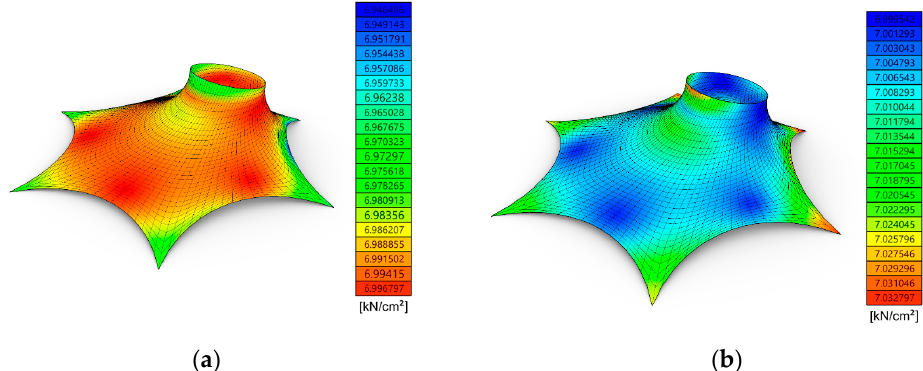
Figure 8. Analysis of tensile forces in form-found membrane in the ( a ) latitudinal and ( b ) longitudinal directions. Differences in tensile forces occur as a function of the directions. Both stocking- and soap-film-based form-finding methods are burdened with built-in errors (elastic deformation forces and scale limits), which also overlap with the digitalization issue. Although very useful for educational reasons, geometrical forms of soap bubbles and membranes are not obvious for everyone; digital form-finding allows us to instantaneously overcome the obstacle of digitalization.